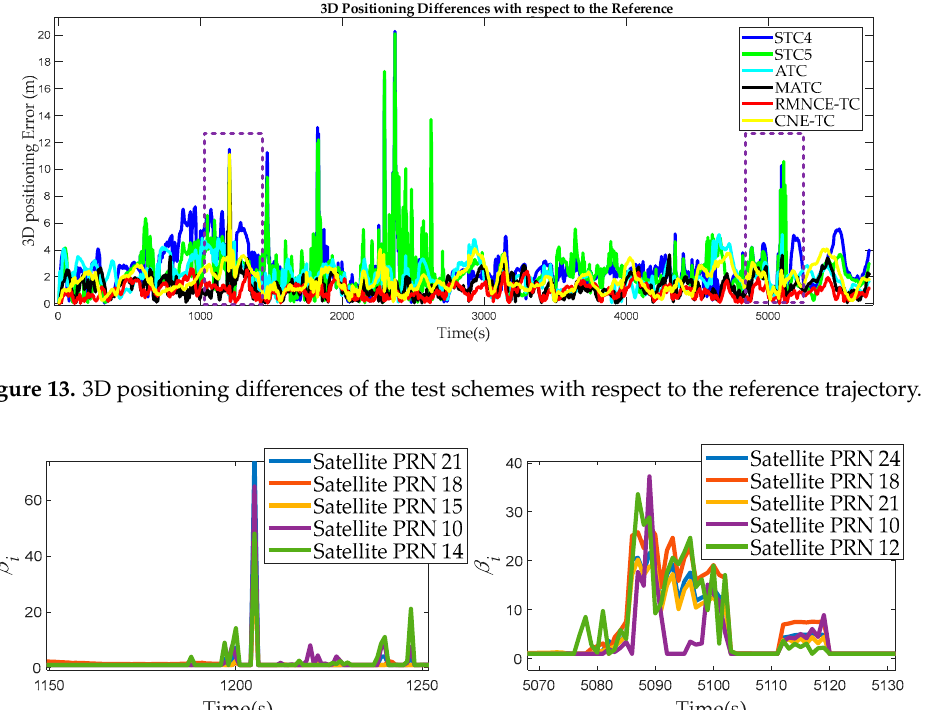
Figure 14. The value of the expanding scale β i with respect to the five pseudo-range measurements: ( a ) 1150 s to 1250 s; ( b ) 5070 s to 5120 s.